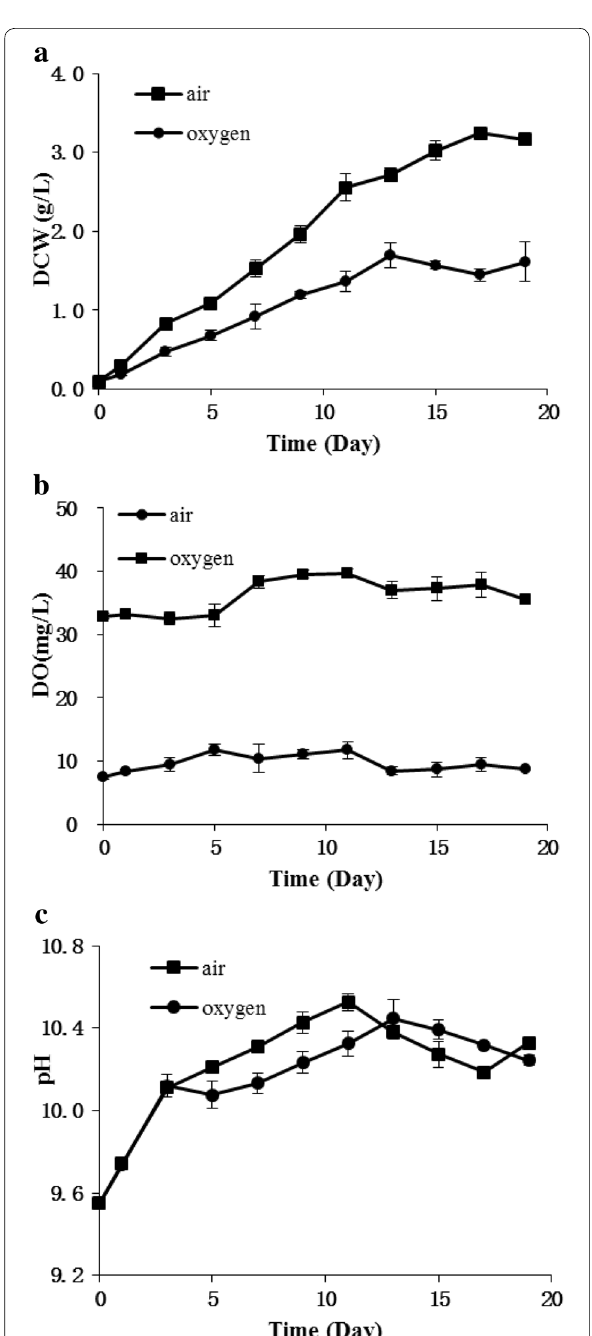
Fig. 6 Culture of Euhalothece sp. ZM001 in tubular PBRs with air and oxygen bubbling: a biomass production; b DO; c pH